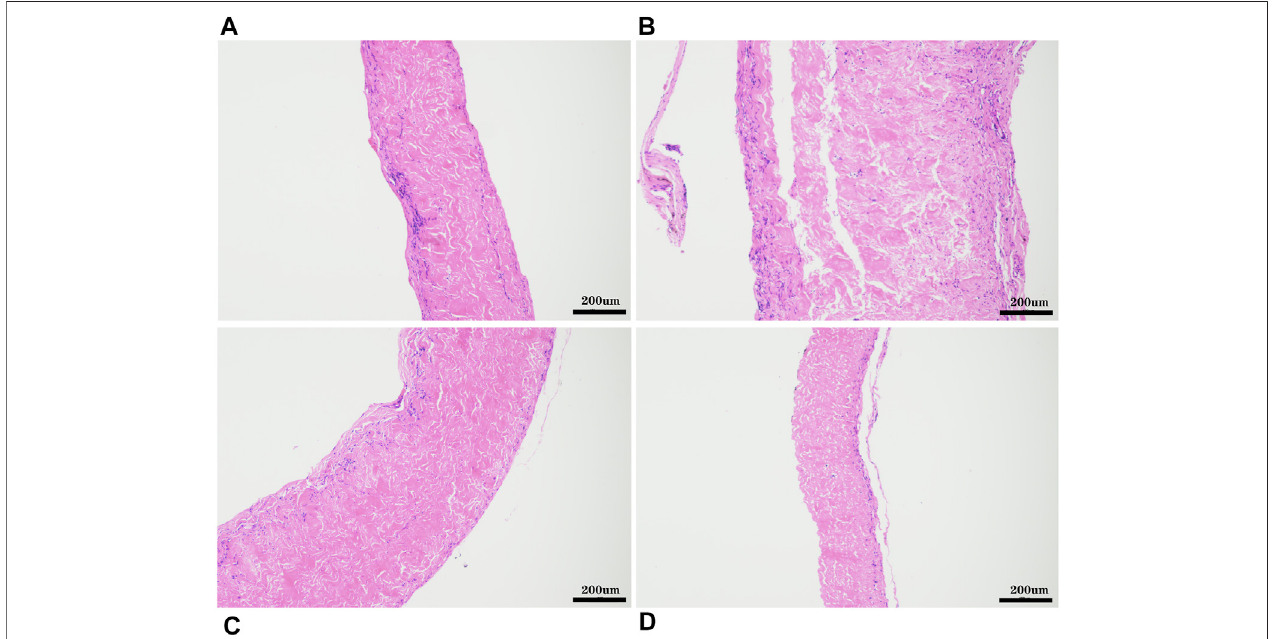
FIGURE 12 | HE staining after 8 weeks of subcutaneous implantation in rats, (A) , GA- yak pericardium; (B) , GA- Australian bovine pericardium; (C) , GA- local bovine pericardium; (D) , GA- porcine pericardium. scale bars are 200 um.